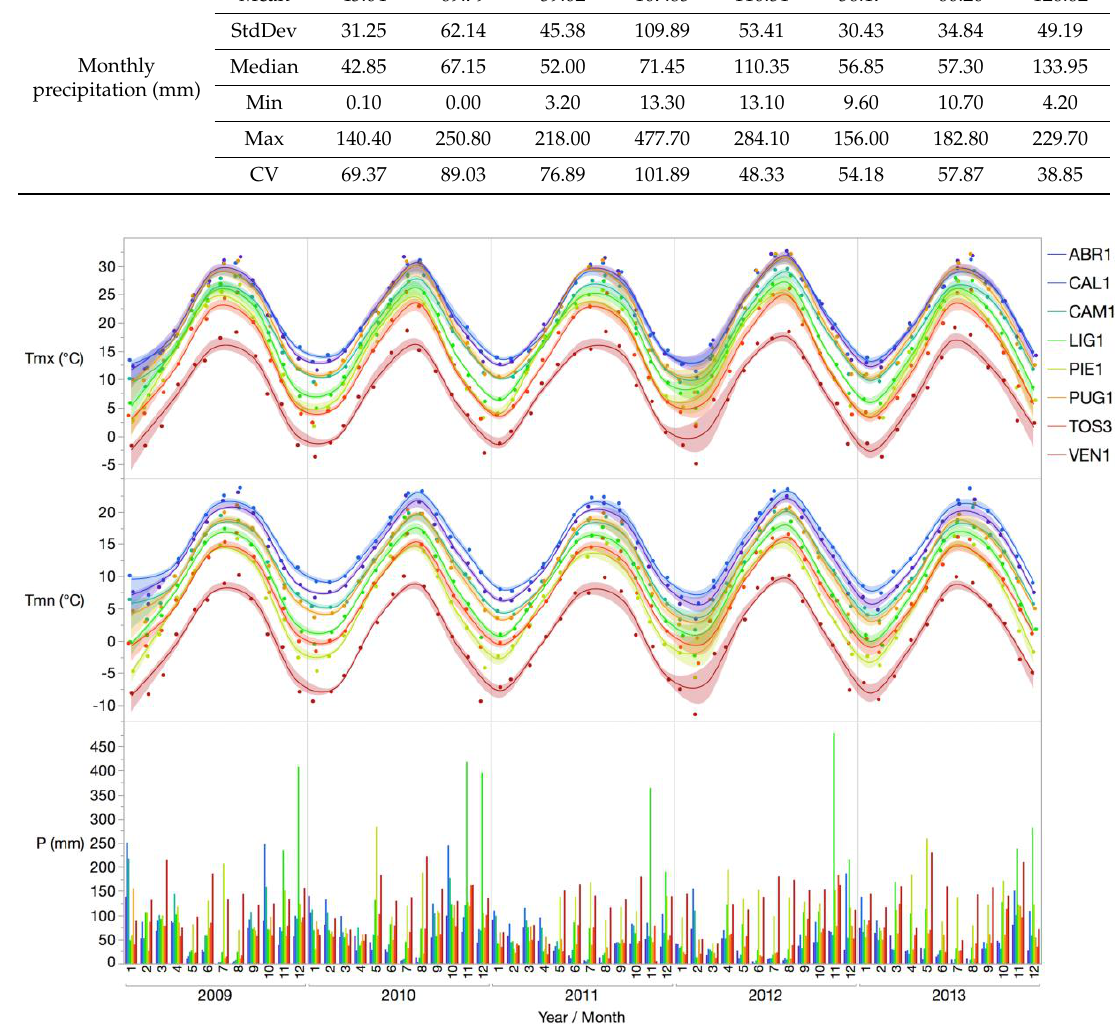
Figure 2. Monthly variation of Minimum air temperature (Tmn), Maximum air temperature (Tmx) and Precipitation (P), by site.